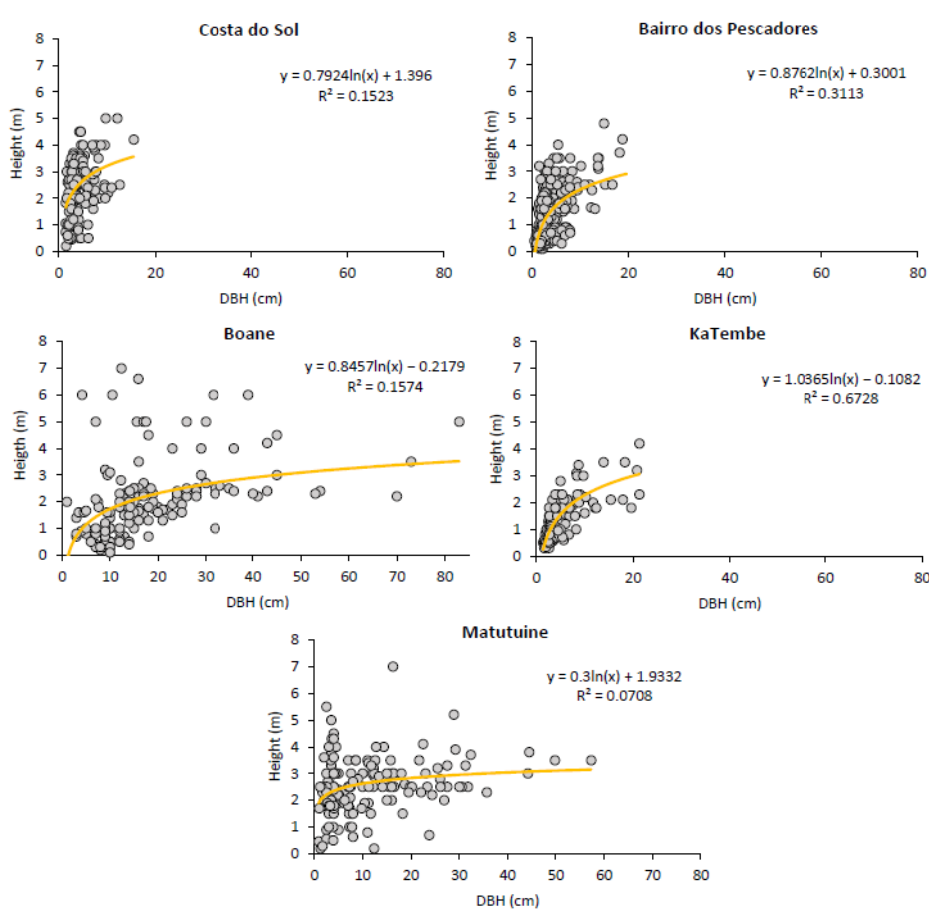
Forests 2022 , 13 , x FOR PEER REVIEW